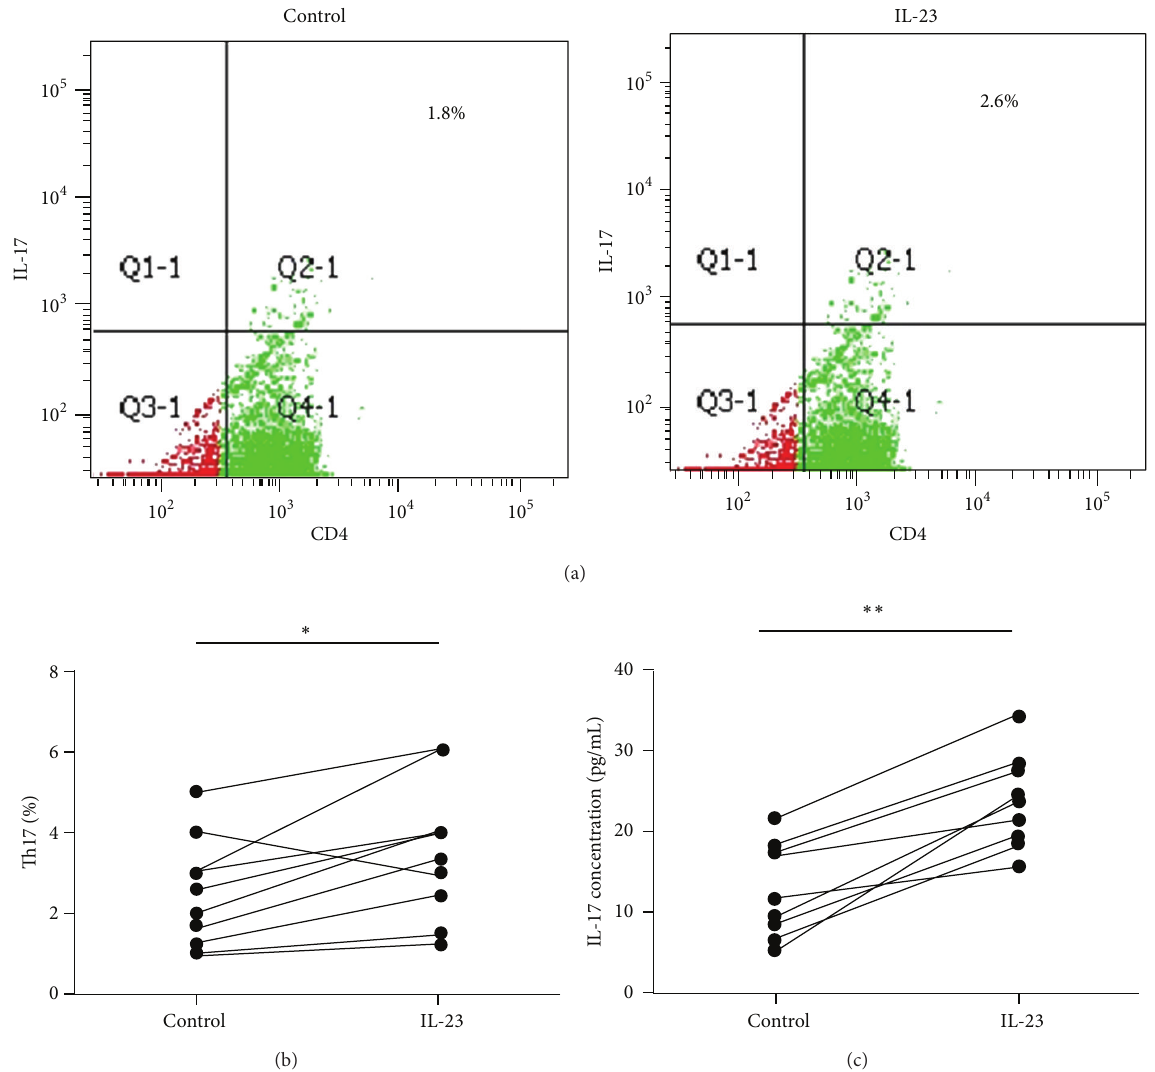
Figure 4: The effect of recombinant (r) IL-23 on the percentage of Th17 cells and IL-17 production in CD4+T cells from OLP patients. (a) Representative scatter plots of CD4+IL-17+ staining in peripheral blood CD4+T cells from OLP patients ( 𝑛 = 10 ), with or without the stimulation of rIL-23 (20ng/mL) for 36 h. ((b) and (c)) Paired comparisons of percentages of Th17 cells (b) and the IL-17 content in the culture supernatant (c) in peripheral blood CD4+T cells from OLP patients ( 𝑛 = 10 ), with or without the stimulation of rIL-23 (20 ng/mL) for 36